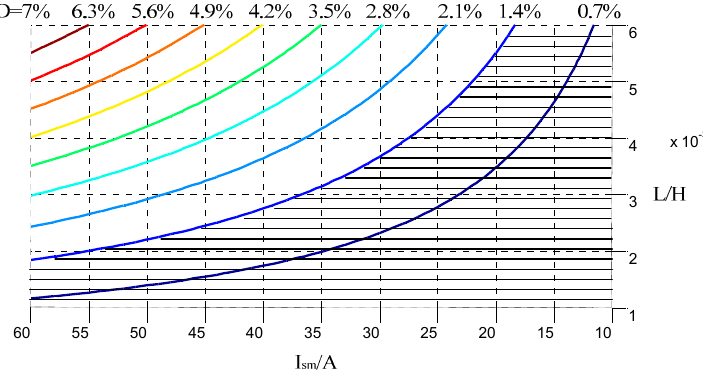
Figure 12. Contour line of current THD under a unity power factor.